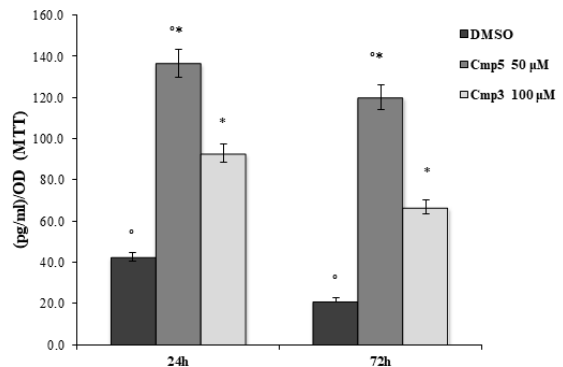
Figure 8. ELISA assay in C6 rat glioma cells in the presence of Cmp 3 and Cmp 5 . PGE2 secretion levels, measured after 24 and 72 h, are reported as pg/mL/OD MTT values. Data shown are the mean (± SD) of three different experiments. Cmp 5 50 μ M vs ctrl, *Cmp 3 100 μ M vs Cmp 5 50 μ M p < 0.05.